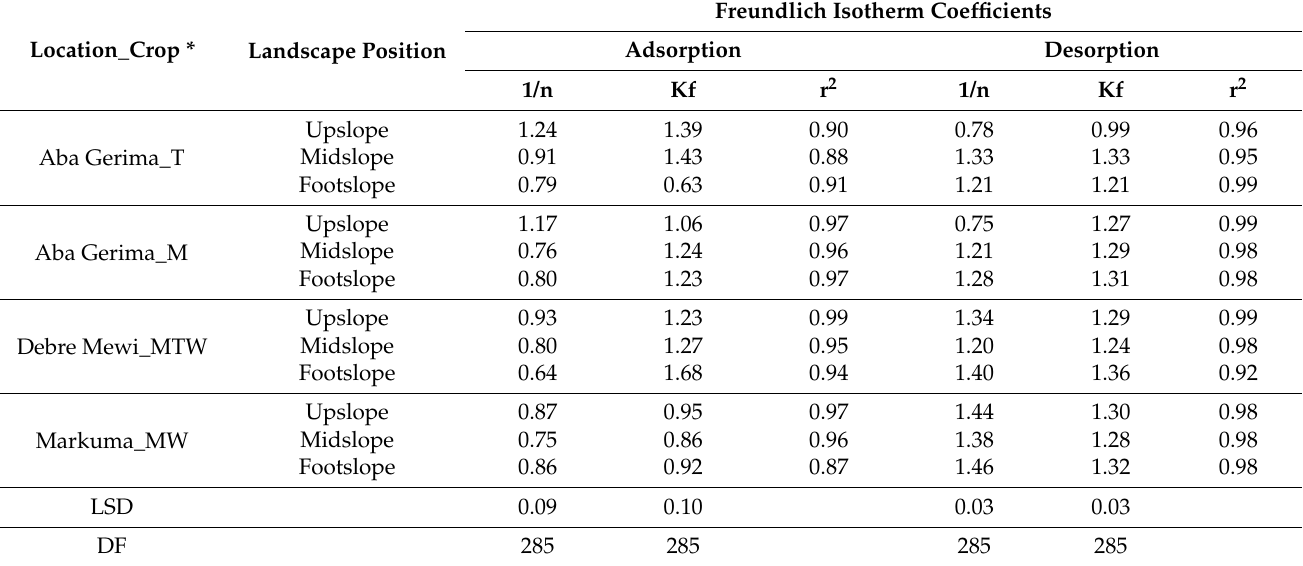
Table 5. Freundlich coefficients for adsorption and desorption